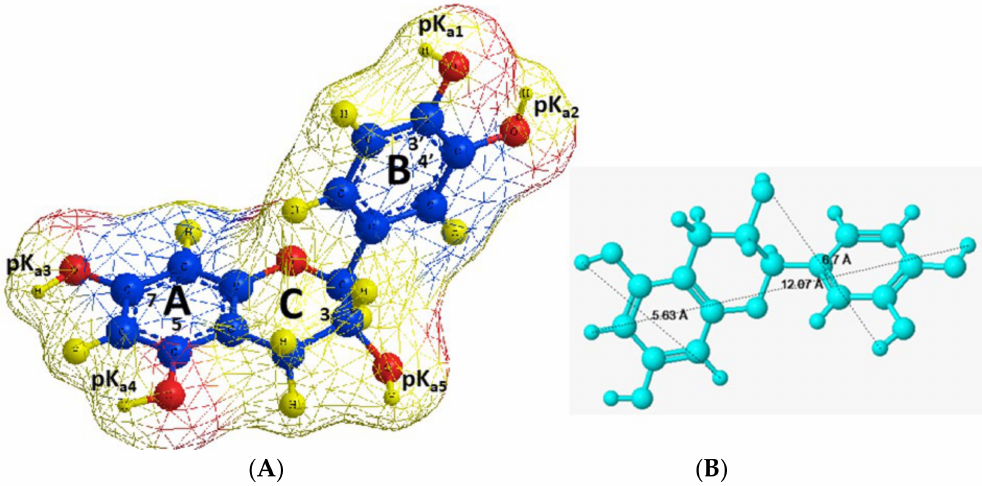
Figure 7. Catechin molecular structure, physicochemical, and molecular characteristics: ( A ) pK a values: pK a1 ≈ 9.5, pK a2 ≈ 8.9, pK ≈ 8.2–8.6, pK ≈ 10.3–11.2, pK ≈ 13.2–14.8 [53,54]. Connolly molecular area = 211.481 Å 2 . ( B ) Molecular a3 a4 a5 dimensions